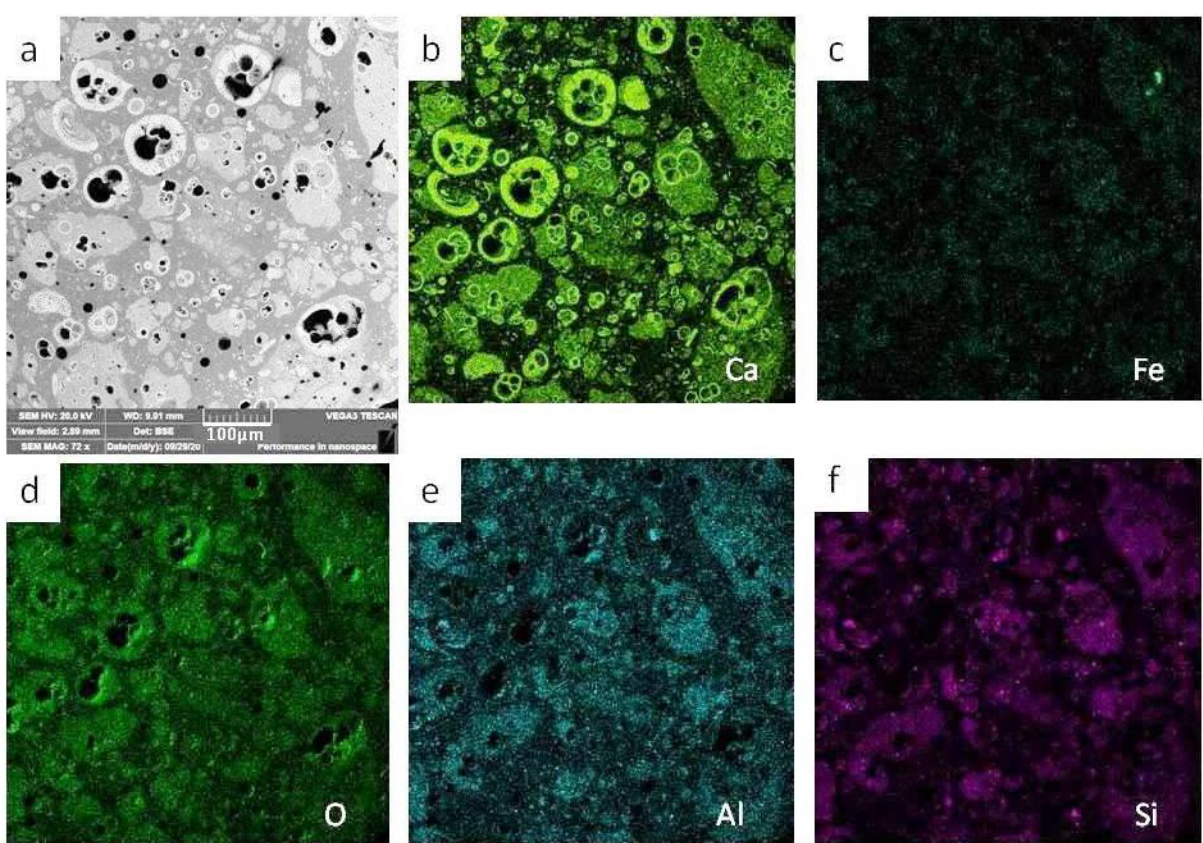
Figure 9. SEM images of the background core 215k, the sediment layer of 100–110 cm; ( a ) back scattered electrons image; b–e: maps of elements’ distribution: ( b ) Ca, ( c ) Fe, ( d ) O, ( e ) Al, ( f ) Si. Dark areas are the epoxy resin cementing fragments of clay-carbonate sediment with microfossils.